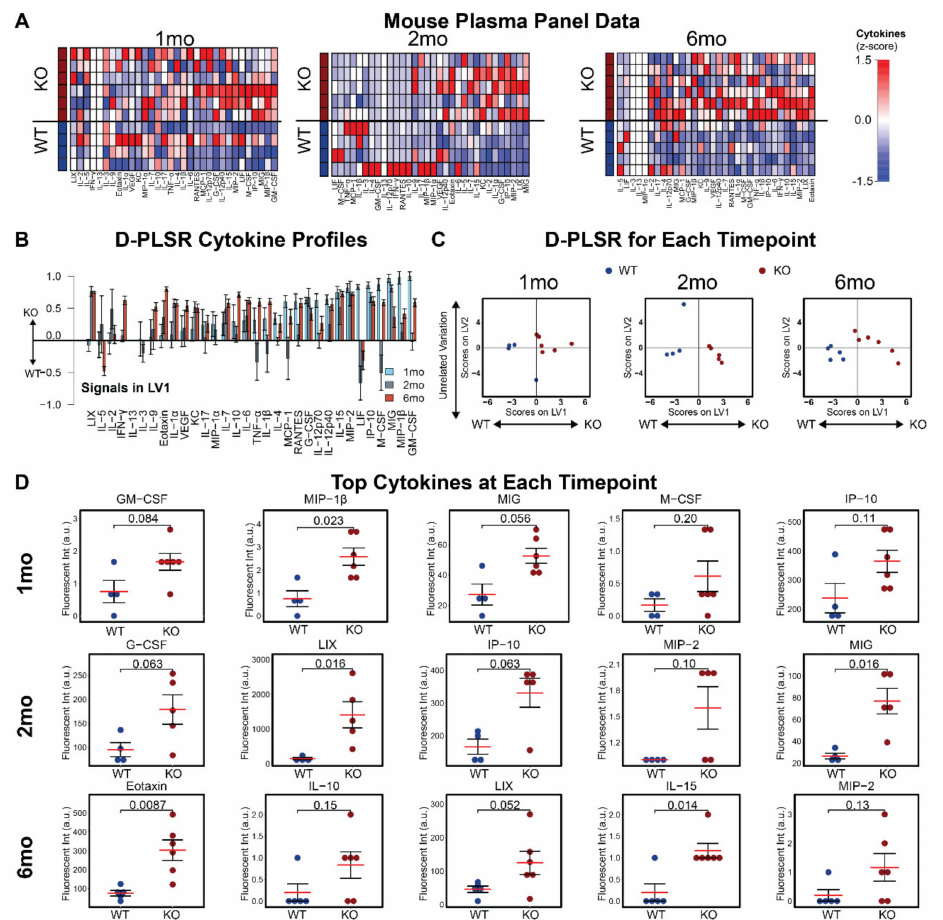
Figure 3. Plasma cytokine signatures distinguish male Mcoln1 − / − mice from wild-type controls. ( A ) A panel of 32 cytokines quantified from blood plasma in WT and Mcoln1 − / − (KO) animals at 1 ( N = 4 WT, 6 KO), 2 ( N = 4 WT, 5 KO), and 6 ( N = 5 WT, 6 KO) months of age using a multiplexed immunoassay (each column is z-scored). ( B ) D-PLSR analysis at each timepoint reveals